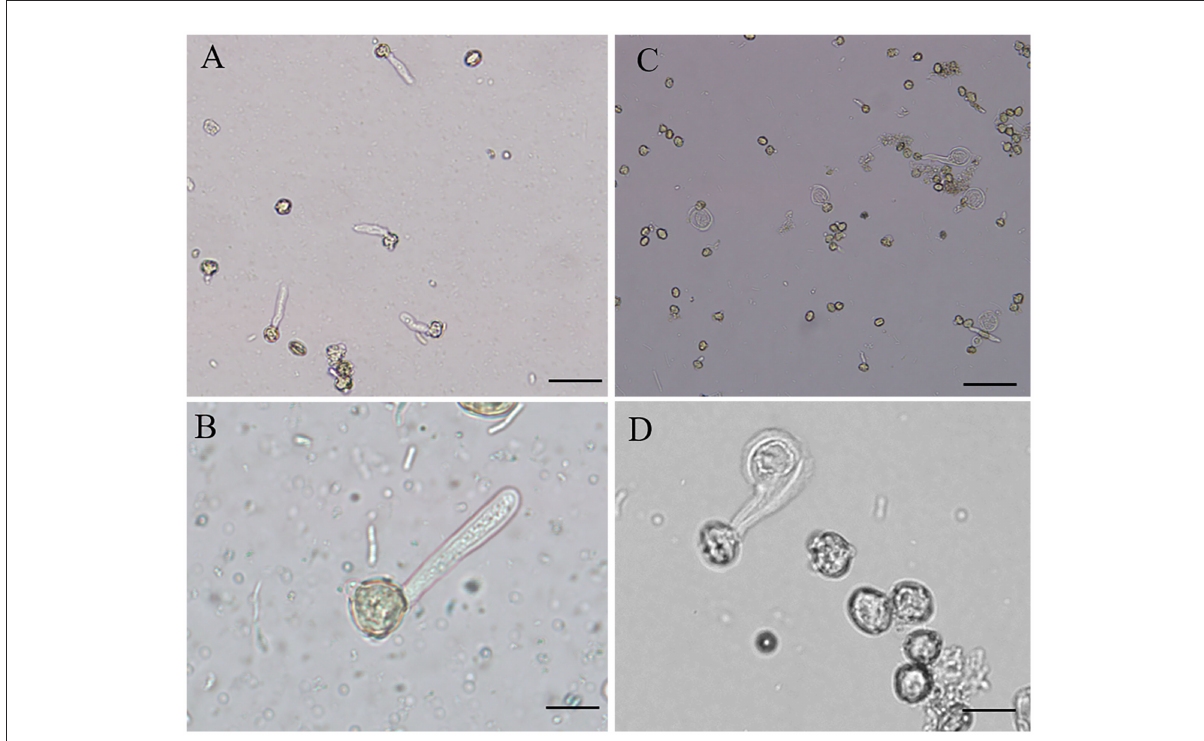
FIGURE1 Morphology of Castanea mollissima pollen tubes under different culture conditions. Bar = 50 µ m in A and C. Bar = 20 µ m in B and D. (A,B) Pollen tubes in control medium. (C,D) Pollen tubes in B toxicity medium.